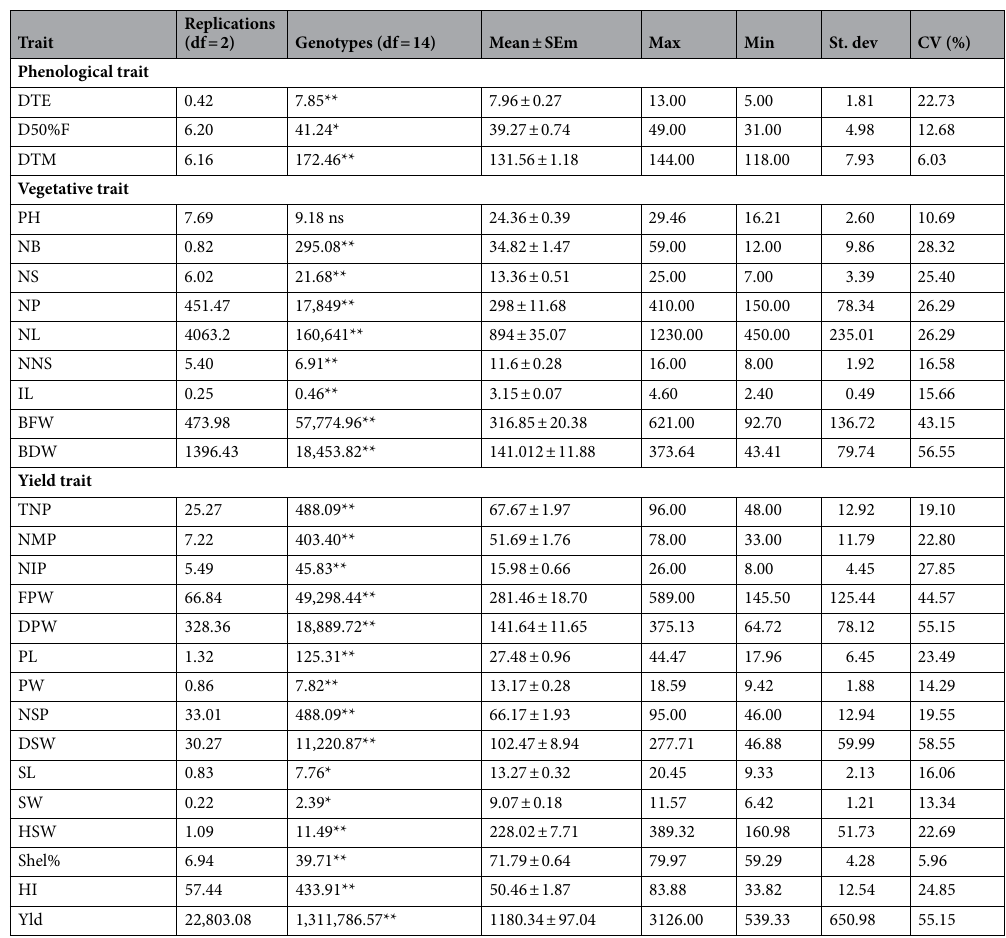
Table 3. Summary of the signification variation revealed by analysis of variance (ANOVA). df degree of freedom; ns non-significant; SEm standard error of the mean; St. Dev standard deviation; Max maximum; Min minimum; P ≤ 0.05 = significant (*); P ≤ 0.01 = highly significant (**), CV coefficient of variation for error, DTE (day) days to emergence, D50%F (day) days to 50% flowering, DTM (day) days to maturity, PH plant height (cm), NB number of branches per plant, NS number of stems per plant, NP number of petioles per plant, NL number of leaves per plant, NNS no. of nodes per stem, IL (cm) inter nodes length, BFW (g) biomass fresh weight per plant, BDW (g) biomass dry weight per plant, TNP total no. of pods per plant, NMP number of mature pods per plant, NIP number of immature pods per plant, FPW (g) fresh pods weight, DPW (g) dry pods weight, PL (mm) pod length, PW (mm) PW, NSP number of seeds per plant, DSW (g) dry seed weight per plant, SL (mm) seed length, SW (mm) seed width, HSW (g) hundred seed weight, Shel% shelling percent, HI (%) harvest index , Yld (kg ha −1 ) yield